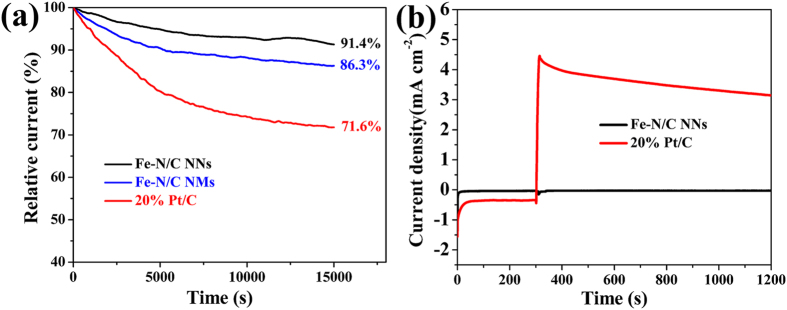
(a) Chronoamperometric response of Fe-N/C NNs, Fe-N/C NMs and Pt/C in O2-saturated 0.5 M H2SO4 at 0.75 V. (b) Chronoamperometric response with 3 M methanol in O2-saturated 0.5 M H2SO4 at 0.75 V.